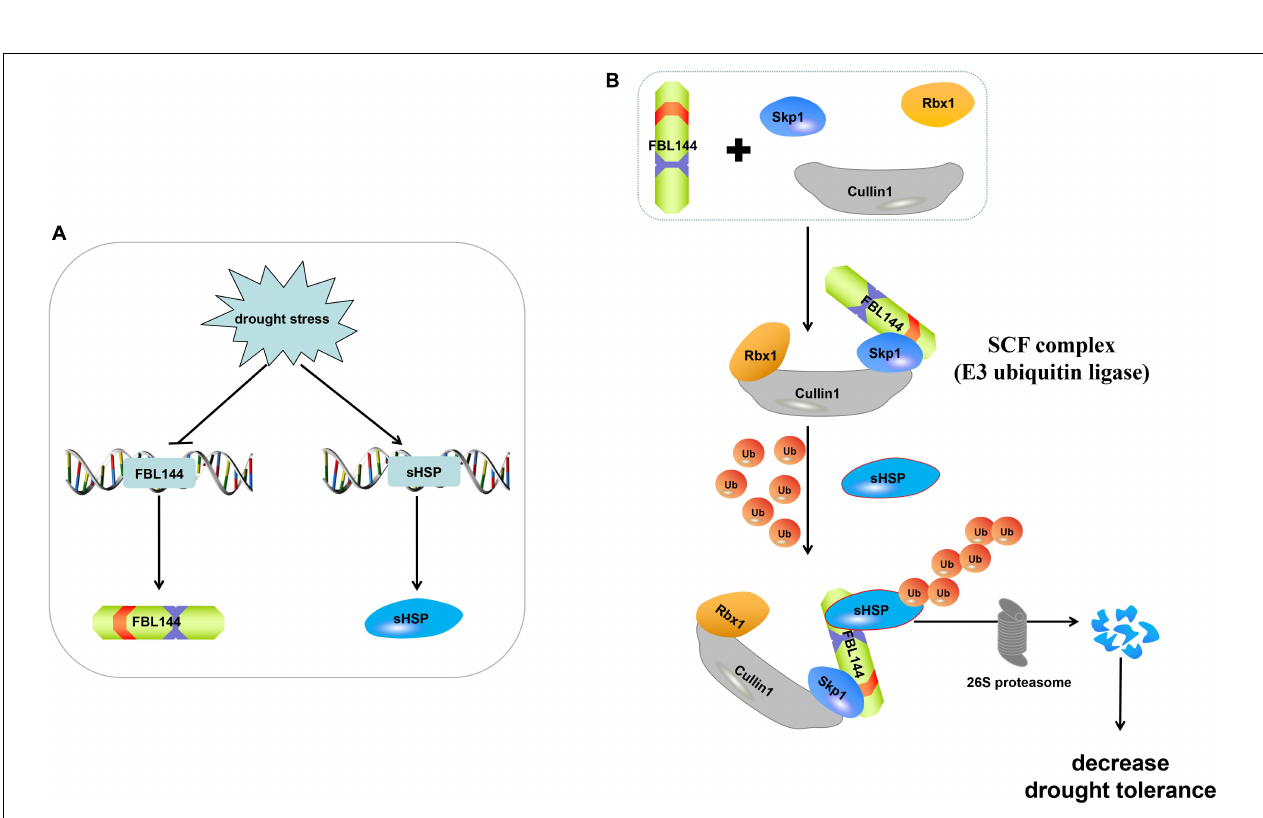
FIGURE 8 | Model for molecular mechanism of GmFBL144. (A) In response to drought stress, GmsHSP was increased through the inhibition of GmFBL144 . (B) GmFBL144 can form SCF FBL 144 with Skp1 and Cullin1 to promote the ubiquitinated degradation of GmsHSP by 26S proteasome, which reduces plants drought